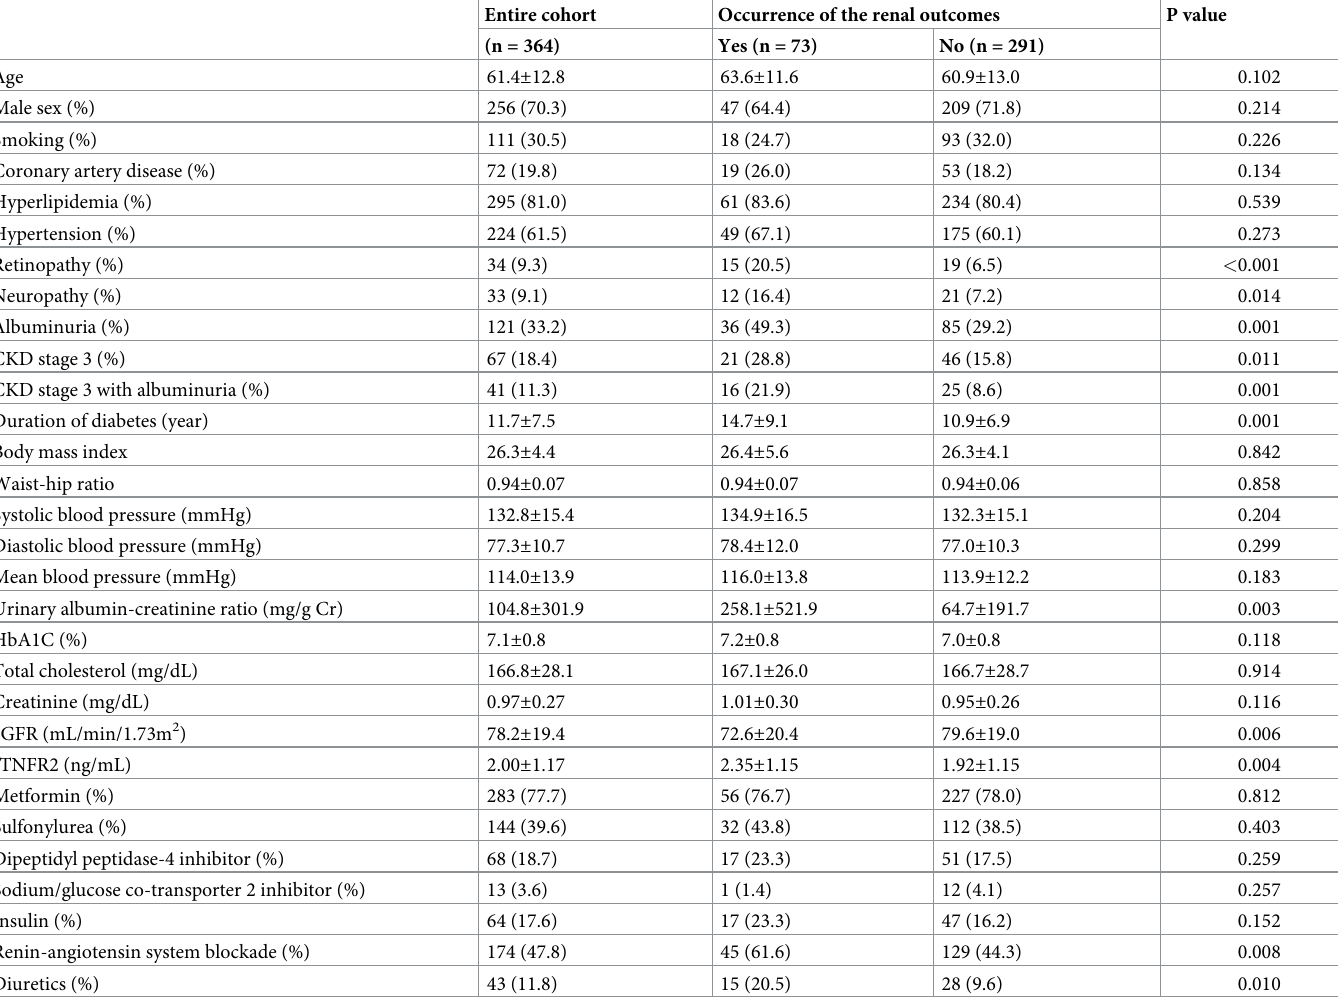
Table 1. Baseline characteristics of the entire study population and according to the occurrence of the renal outcomes. Entire